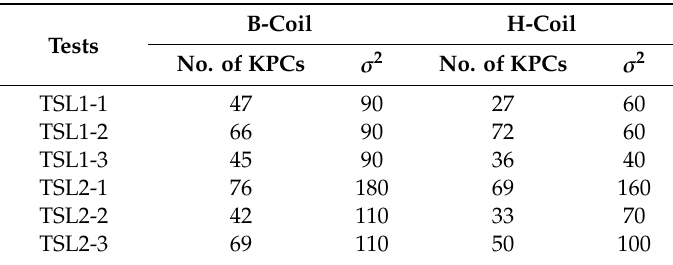
Table 2. Estimatedparameterswhen m = 10(No. Table 2. Estimated parameters when m = 10 (No. of KPCs represents the number of kernel principal components).